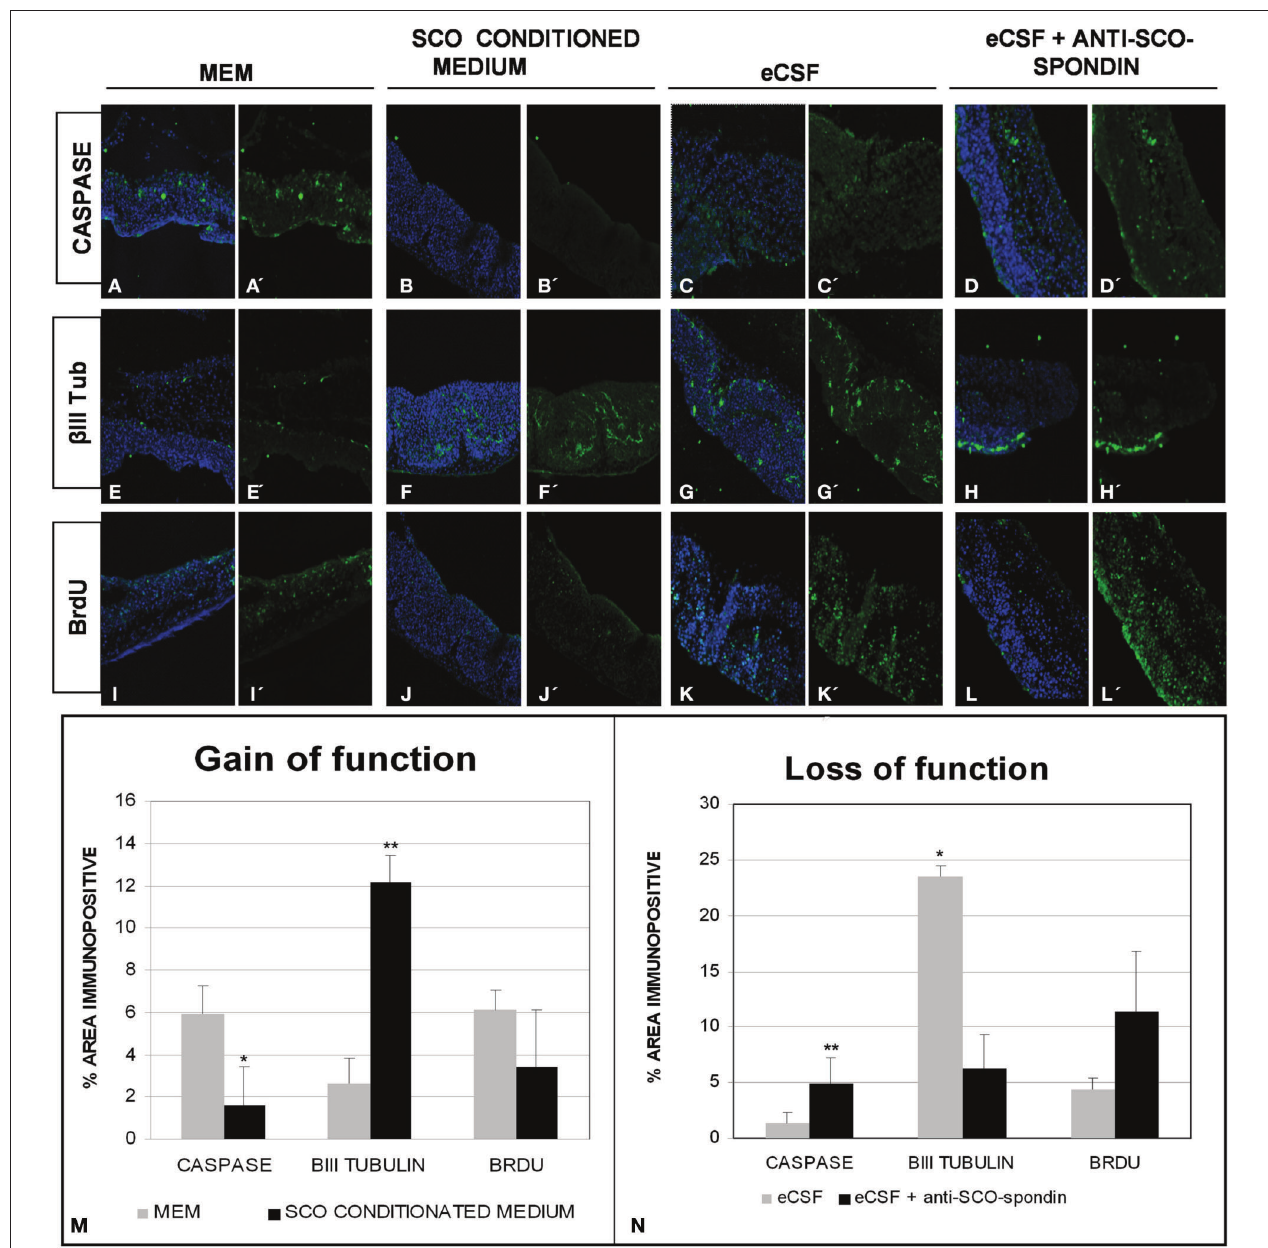
FIGURE 8 | SCO-spondin regulates the behavior of mesencephalic cells in vitro . Optic tectum explants from HH20 embryos cultured in presence of DMEM (A,E,I) ; SCO conditioned DMEM (B,F,J) ; DMEM supplemented with 20% eCSF (C,G,K) ; DMEM supplemented with 20% eCSF and incubated with anti SCO-spondin antibody (D,H,L) . The explants were analyzed for the